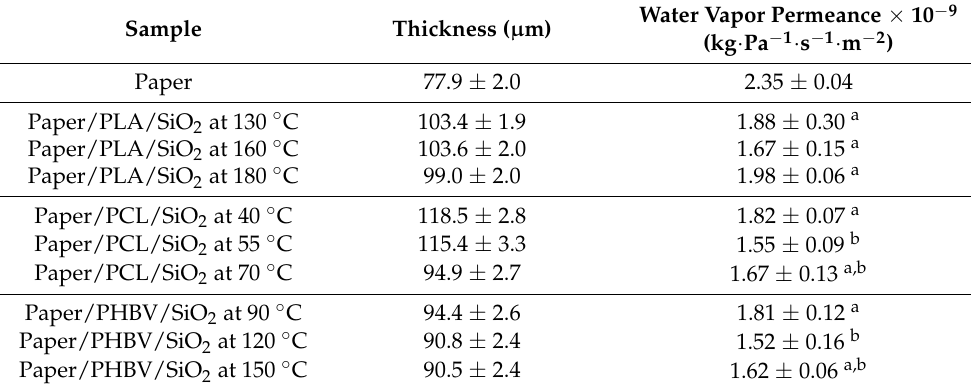
Table 5. Mean thicknesses and water vapor permeance of non-coated and the multilayer struc- tures based on paper, electrospun polylactide (PLA), poly( ε -caprolactone) (PCL), and poly(3- hydroxybutyrate-co-3-hydroxy-valerate) (PHBV) mats, and electrosprayed hydrophobic silica mi- croparticles annealed at different